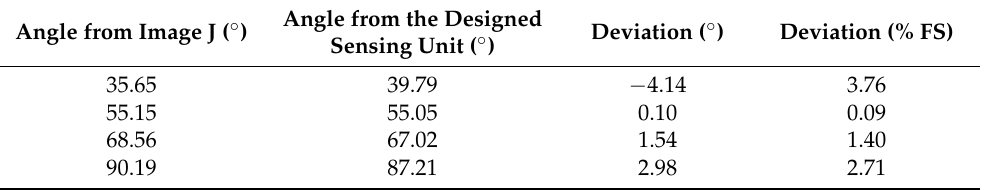
Table 5. Measurement results of Image J and the designed sensing unit.